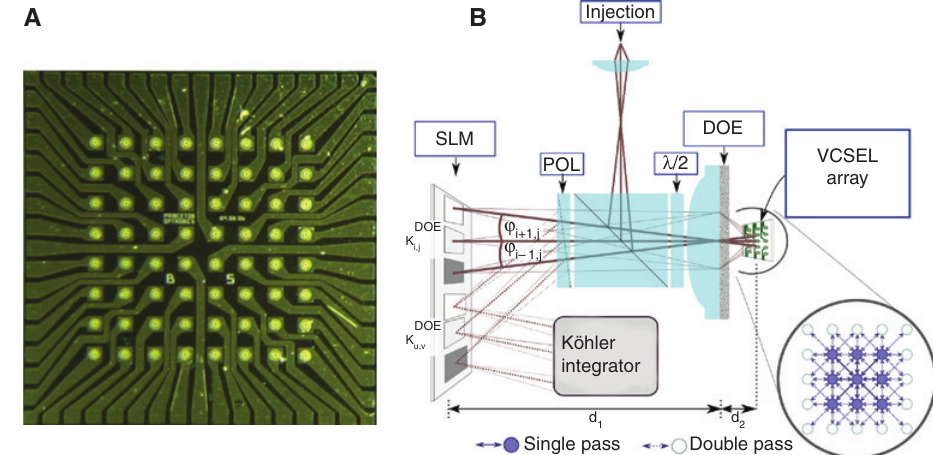
Figure 4: (A) Array in single-mode VCSEL laser diodes, Princeton Optronics. Implementing such an array in a diffractive resonator design creates coupling between individual lasers (panel B) [24]. Such a network can then be injected via a single external laser; readout weights can be implemented via a